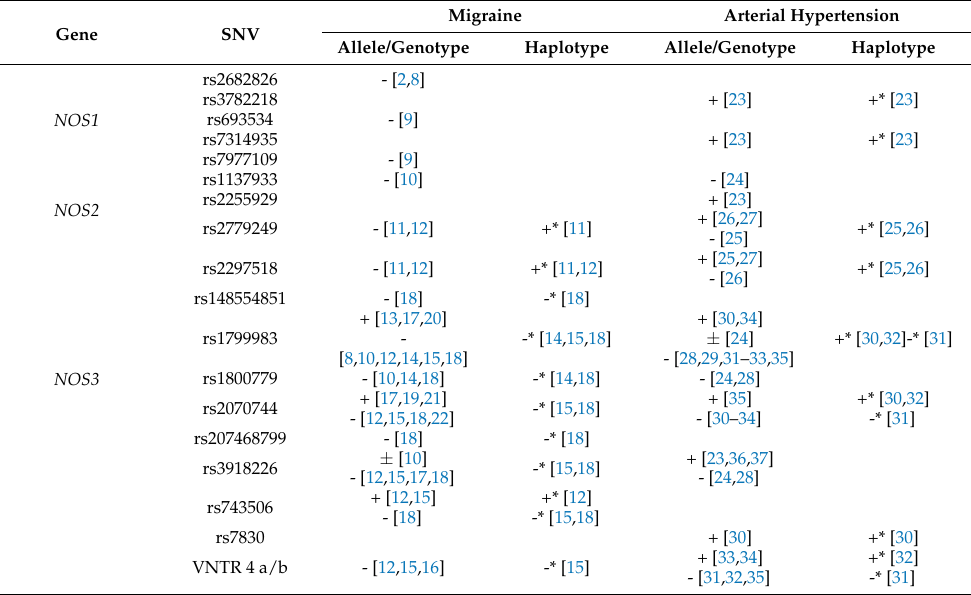
Table 1. Association of genes NOS1 , NOS2 , and NOS3 SNVs with the development of M and AH.